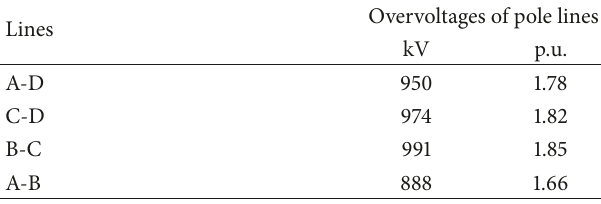
Table 2: Overvoltages of transmission lines under abnormal mode (C station is unconnected).